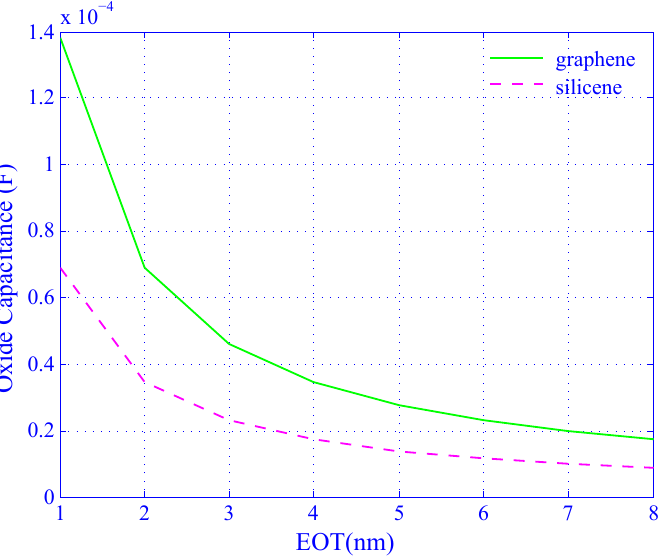
Figure 7. Oxide capacitance decreases with effective oxide thickness (EOT) (nm) for both silicene (dotted line) and graphene (solid